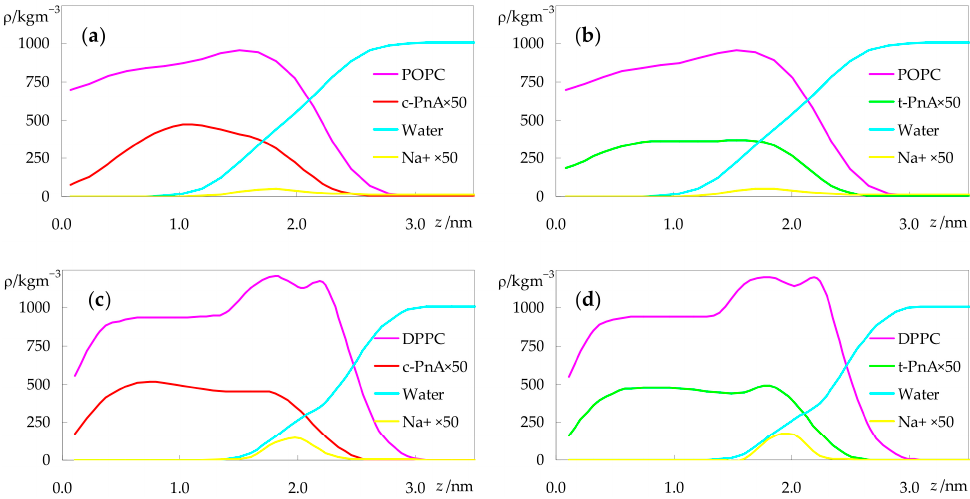
Figure 5. Mass density profiles of the different species in the simulations with c -PnA ( a , c ) or t -PnA ( b , d ), in POPC ( a , b ) or DPPC ( c , d ).